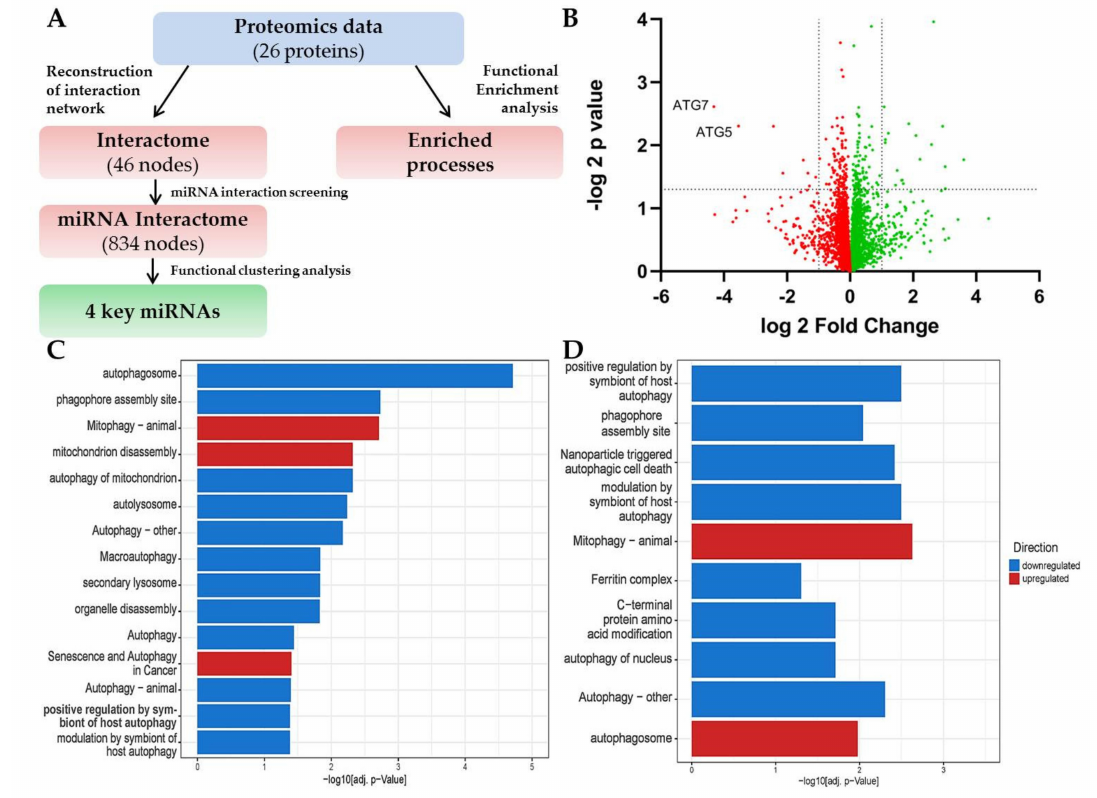
Figure 3. ( A ) Workflow of our comprehensive bioinformatics proteome profiling approach. ( B ) Volcano plotrepresentationofcontrolandATG7MRC-5LS-MSproteomicdata. n = 3, t -test. ( C )Enrichmentanalysis of both downregulated and upregulated proteins, mitophagy and senescence processes highlighted in red. ( D ) Upregulated (red) and downregulated (blue) processes in ATG7-KO-MRC-5